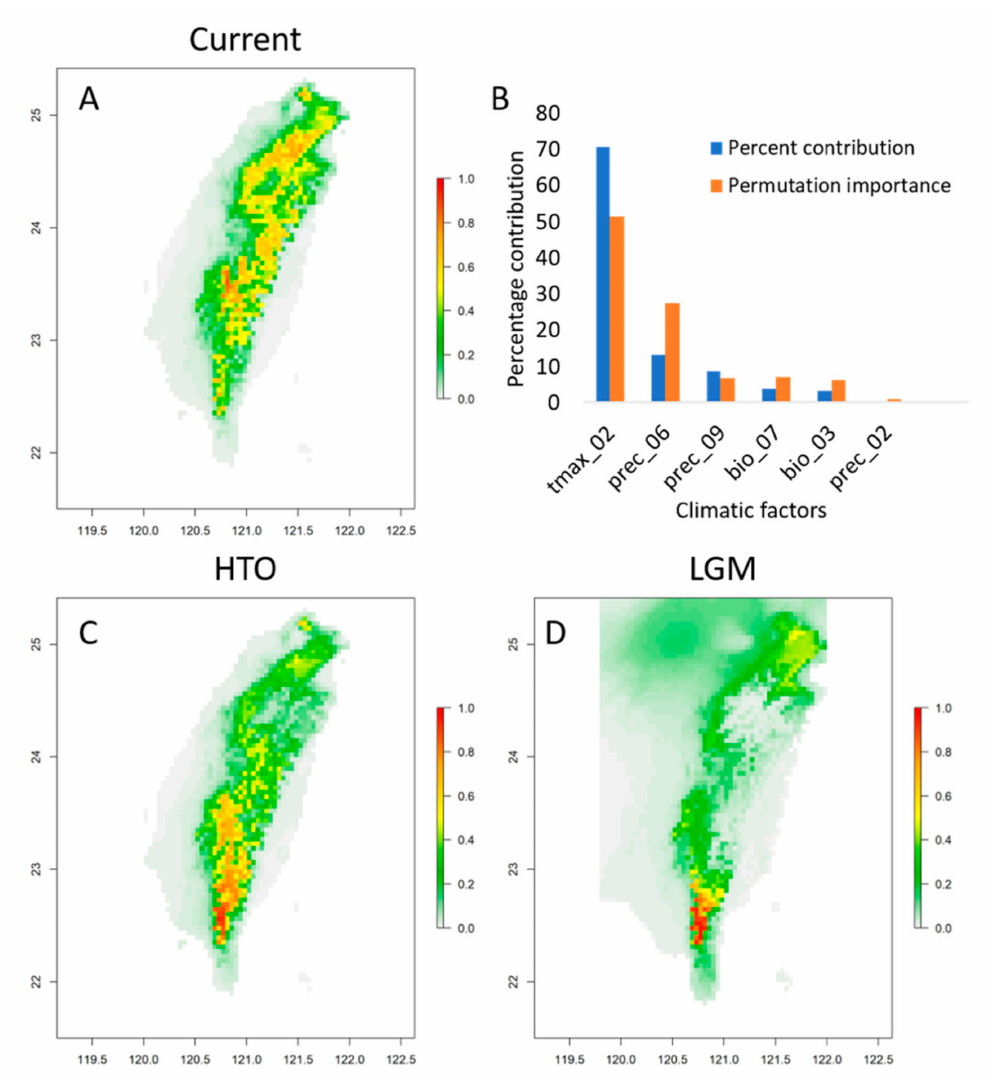
Figure 2. Ecological niche modeling (ENM) of the potential distribution of Acer caudatifolium . ( A ) Current spatial distribution; ( B ) percentage contribution of the predicted climatic factors used for current ENM; ( C ) potential distribution projected in the middle Holocene (Holocene Thermal Optimal, HTO); ( D ) potential distribution projected in the Last Glacial Maximum